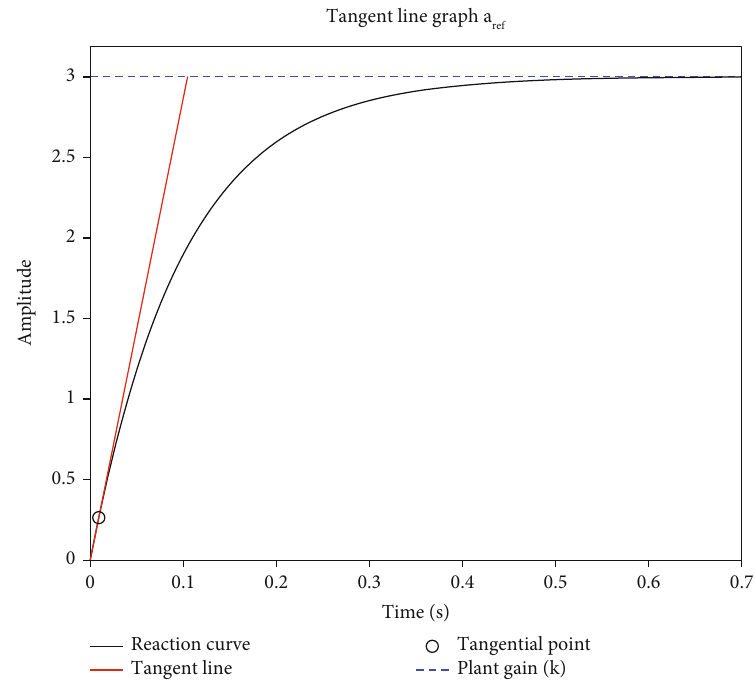
Figure 5: Reaction curve or a